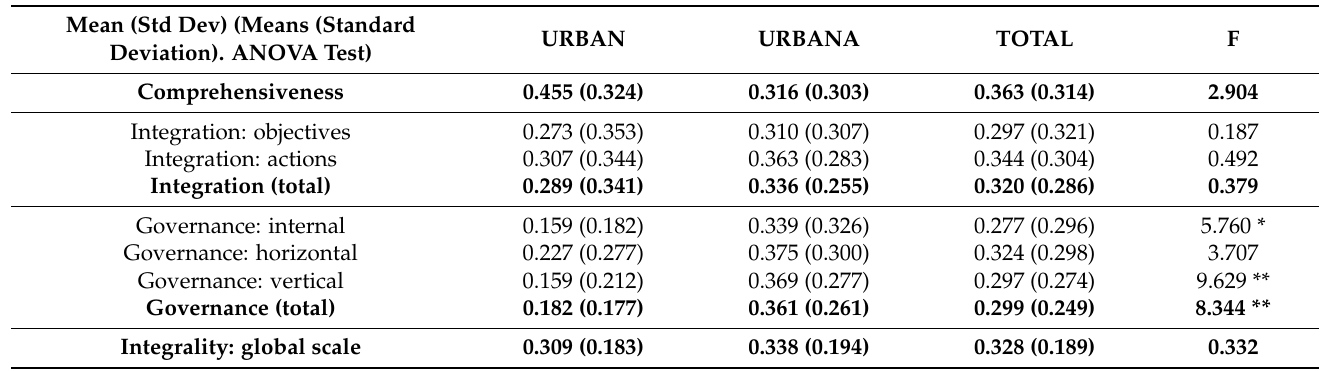
Table 3. Integrality of URBAN and URBANA projects in Spain (1994–2013). Mean (Std Dev) (Means (Standard Deviation). ANOVA